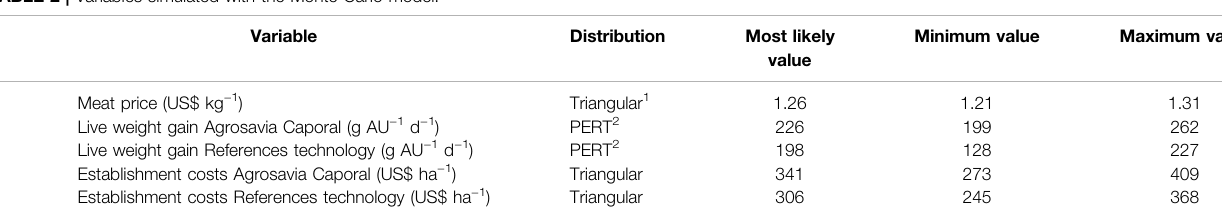
TABLE 2 | Variables simulated with the Monte Carlo